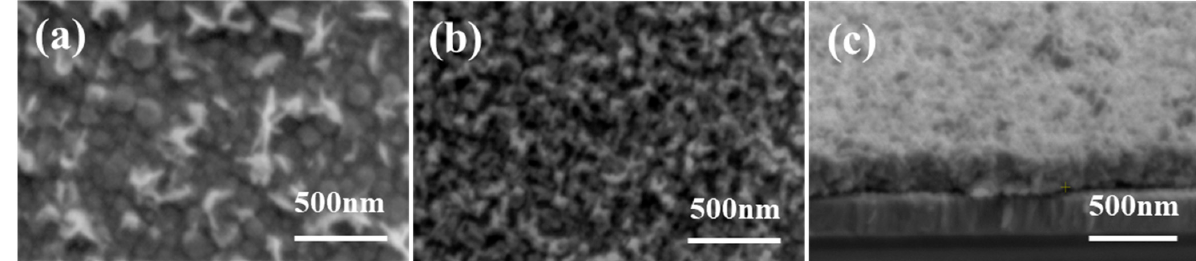
Figure 9. SEM images of ( a ) precursor film, ( b ) iron pyrite film, and ( c ) cross section of iron pyrite film on ITO.